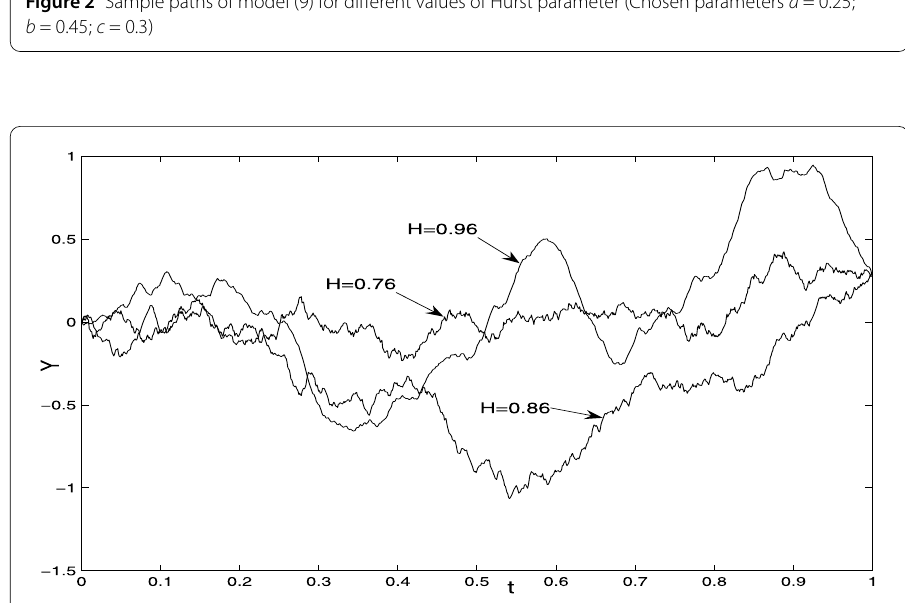
Figure 3 Sample paths of model (9) for different values of Hurst parameter (Chosen parameters a = 0.36; b = 0.28; c =